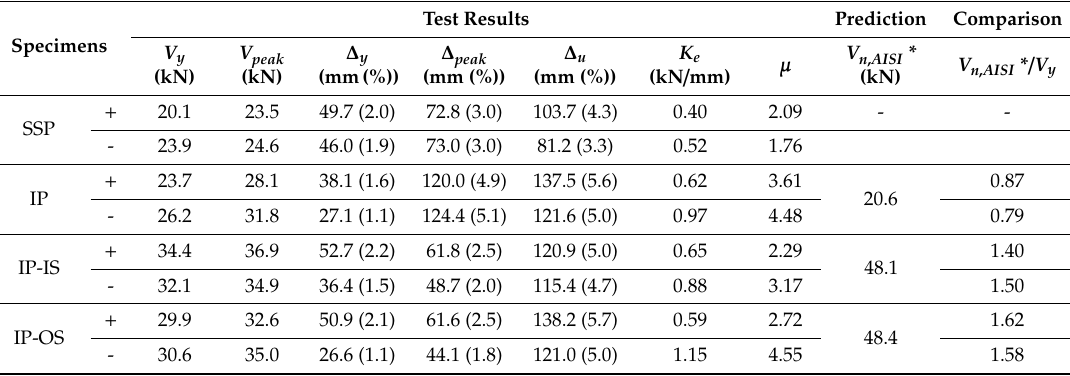
Table 3. Summary of key parameters for the tested